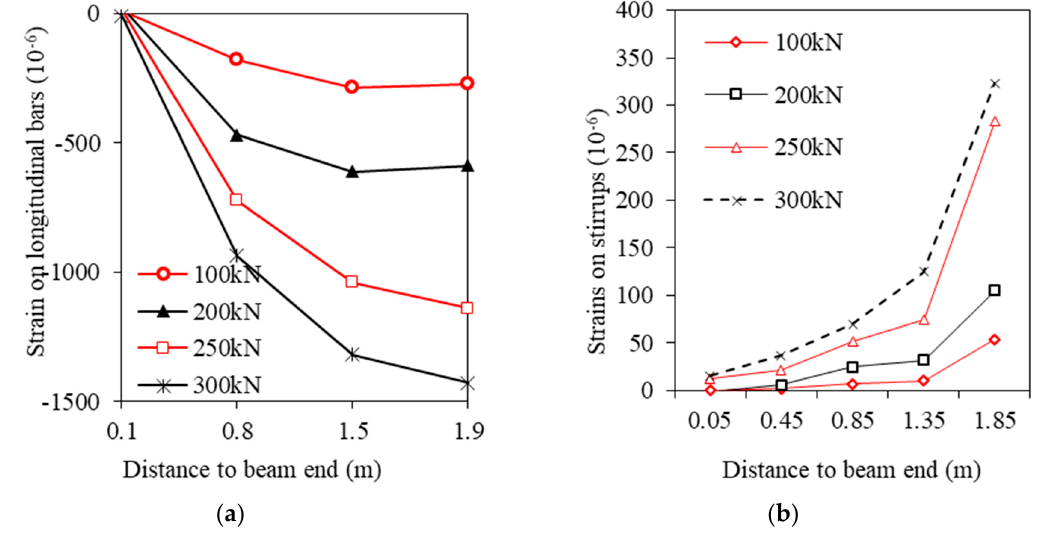
Figure 11. Strain distribution along the right half span of ( a ) the longitudinal bars, and ( b ) the stirrups.